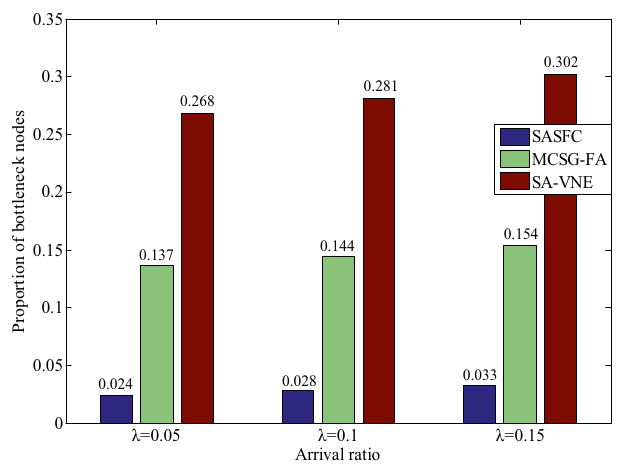
Figure 11. Proportion of bottleneck nodes.